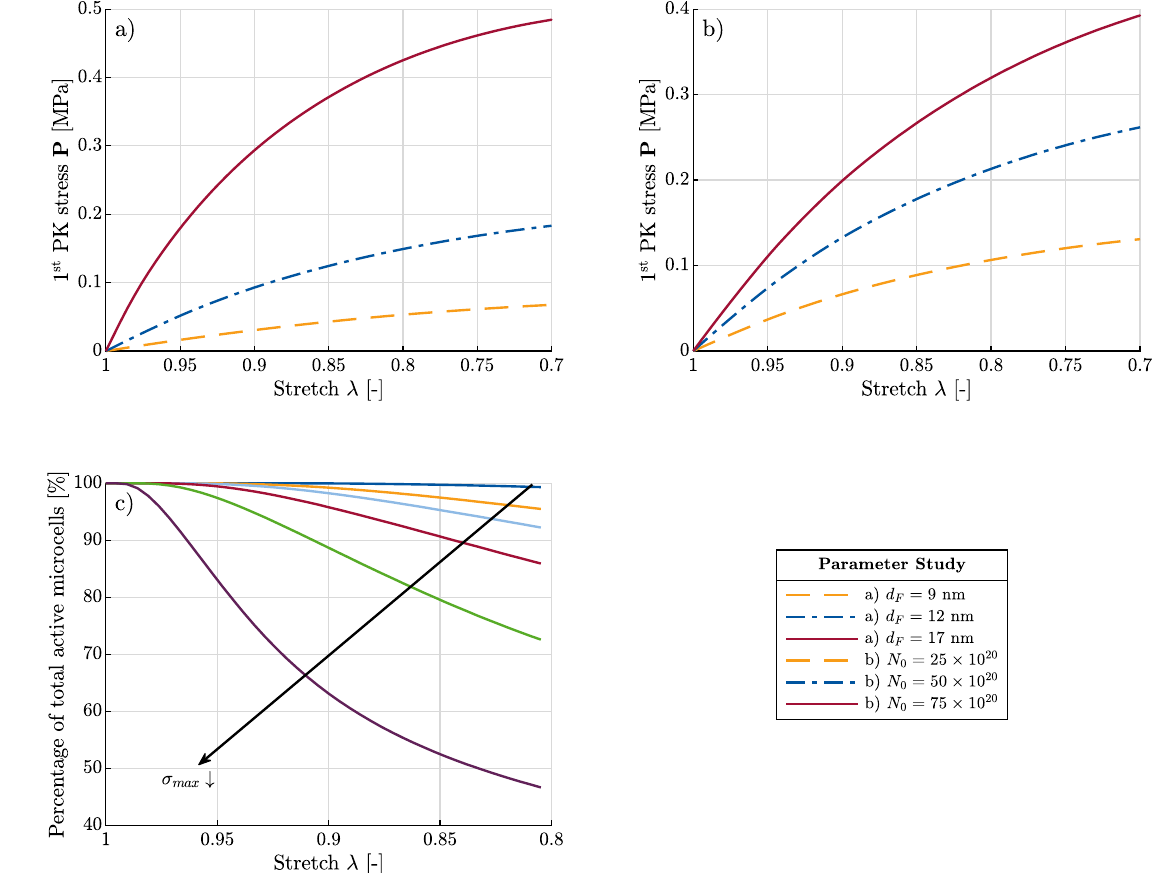
Figure 8. Sensitivity analysis of material parameters: ( a ) and ( b ) stress-stretch diagrams for different values of d F and N 0 , respectively, ( c ) percentage of the active microcells versus stretch for different allowable bending stress